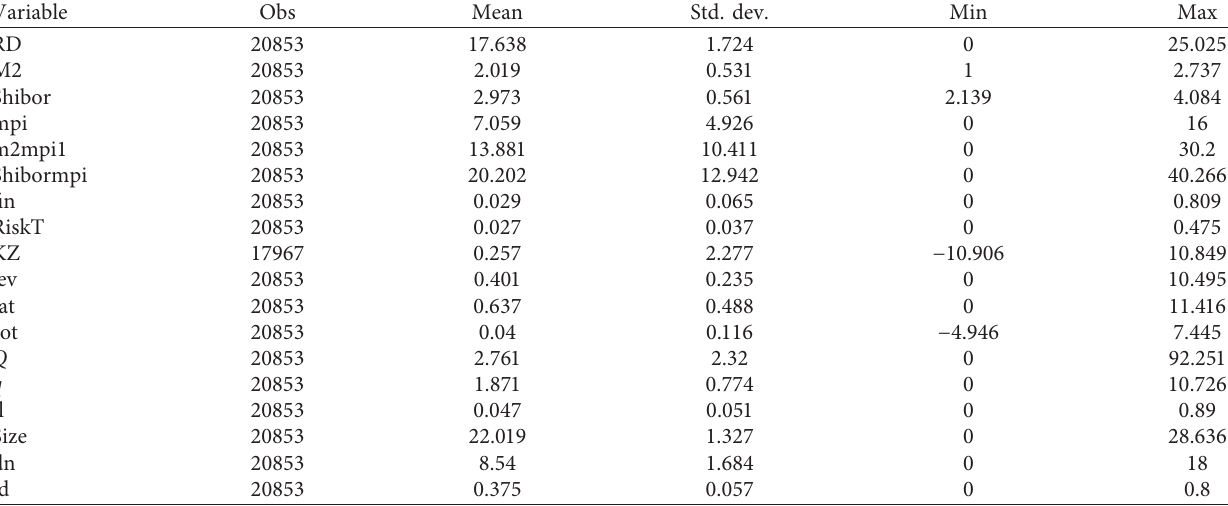
Table 2: Descriptive statistical analysis.